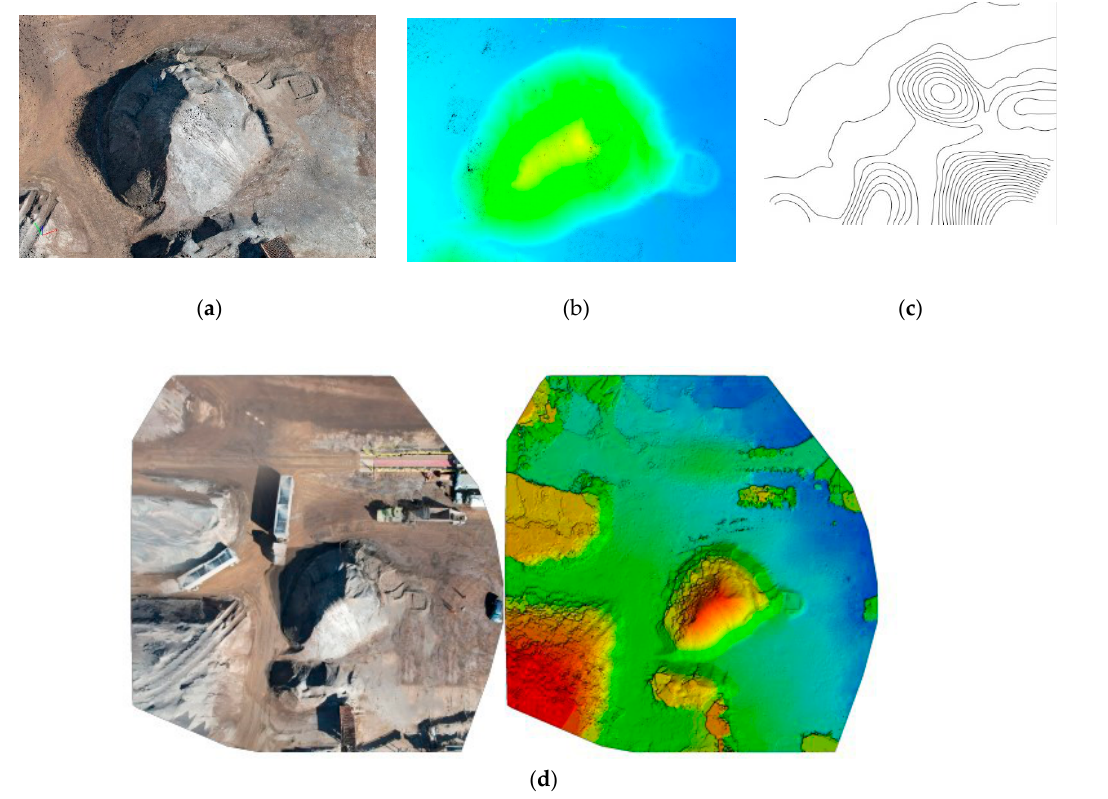
Figure 6. Representation of the generated point cloud model of the quarry site ( a ) Point Cloud Model; ( b ) Altitude Model; ( c ) Contour; ( d ) Orthomosaic Model with its corresponding Digital Surface Model (DSM).